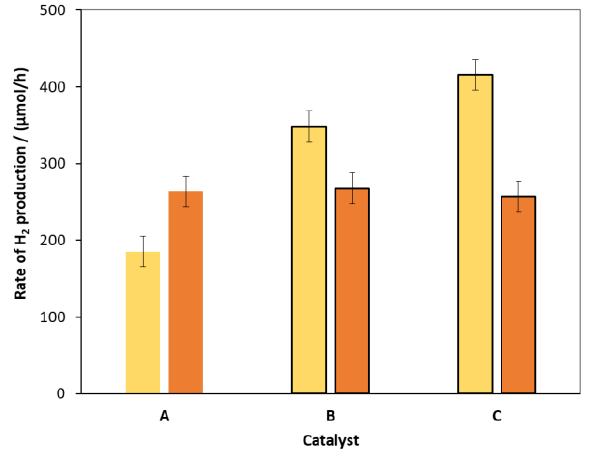
Figure 2. The RHP for unmodified catalysts ( A ) and for catalysts modified with 0.1% Pt ( B ) and 0.1% Ni(II) ( C ) on the surface. Orange and yellow bars represent the hydrothermally treated and untreated catalysts, respectively. The primary volume vs. time functions and their time derivatives (as rate of H 2 evolution) are given in the Supplementary Materials as Figure S2.